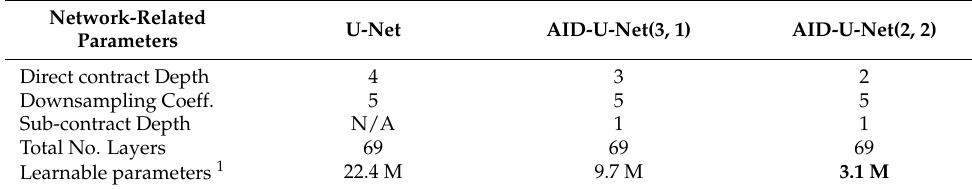
Table 6. Parameter configuration for 3D implementation of U-Net and AID-U-Nets.